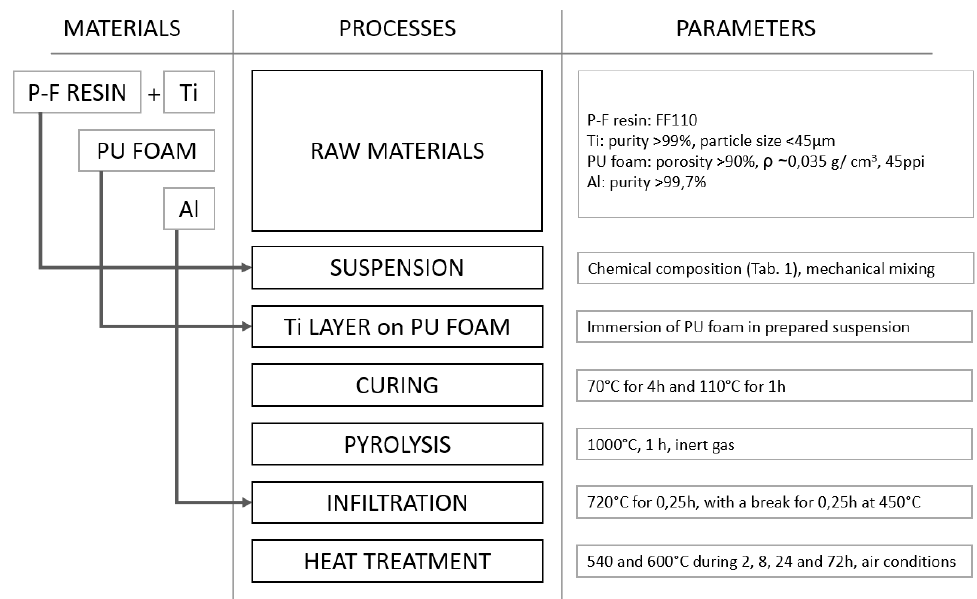
Figure 3. Schematic diagram of processes performed.